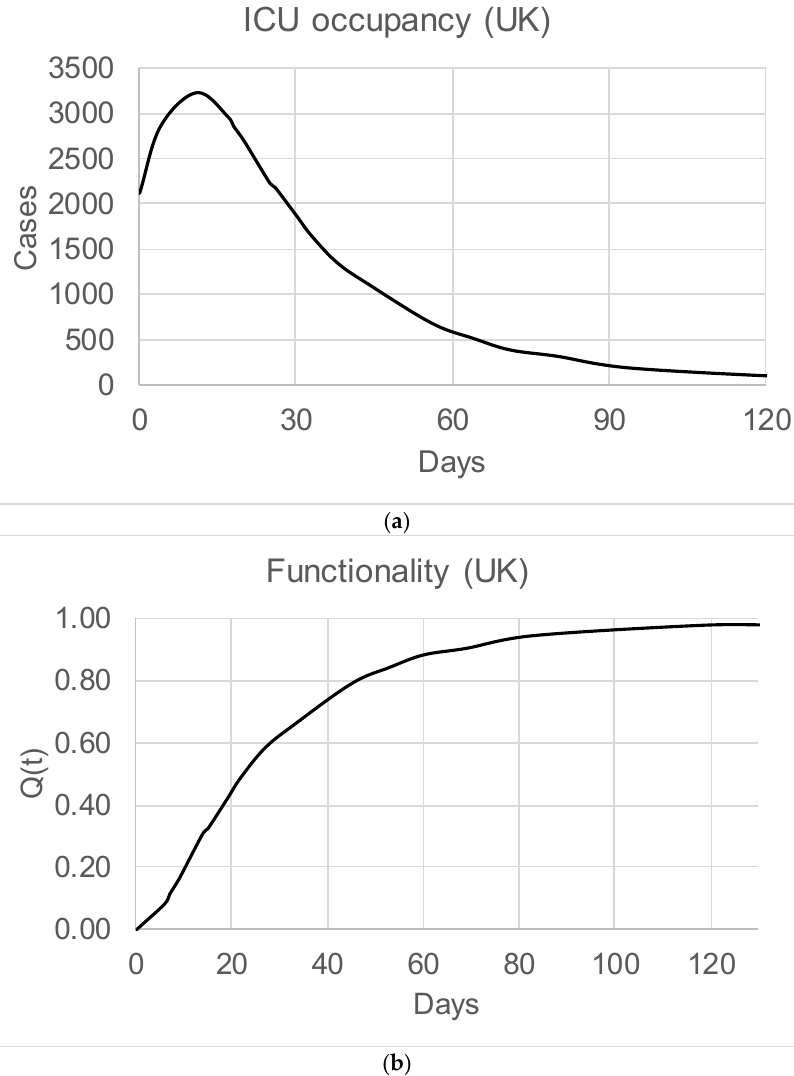
Figure 5. ( a ) Number of COVID-19 patients in ICU in UK from 1 April 2020 to 26 October 2020. Source: UK Government website for data and insights on Coronavirus (COVID-19). ( b ) Health Infrastructure functionality vs. days in UK (T = 133 days).